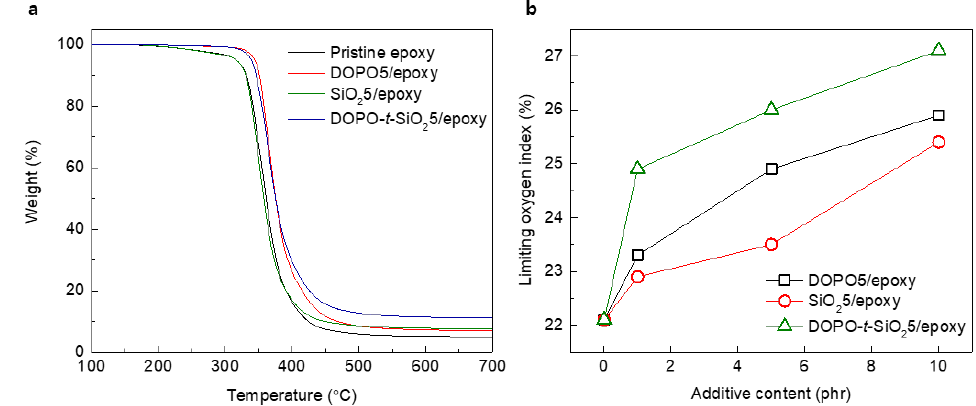
Figure 5. ( a ) Thermogravimetric analysis (TGA) traces of pristine epoxy, DOPO 5 /epoxy, SiO 2 5/epoxy and DOPO- t -SiO 2 5/epoxy nanocomposites, respectively. ( b ) Limiting oxygen index plots of DOPO5/epoxy, SiO 2 5/epoxy and DOPO- t -SiO 2 5/epoxy nanocomposites, respectively. Table 2. Thermal analysis results of pristine epoxy, DOPO / epoxy, SiO 2 / epoxy and DOPO- t -SiO 2 / epoxy nanocomposites, respectively.